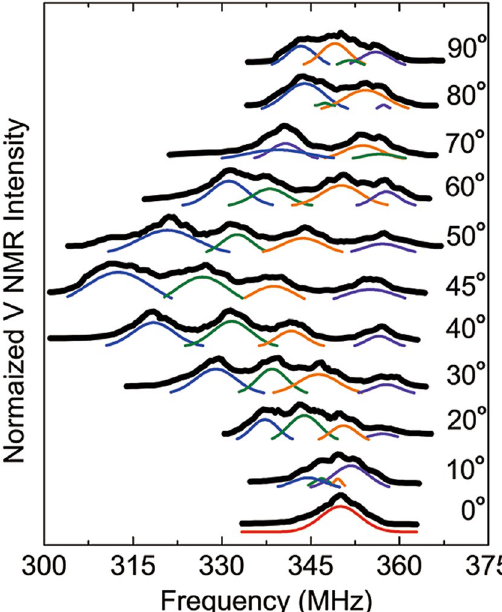
Figure 2. V 3 + NMR spectra of a MnV 2 O 4 single crystal measured at various directions of an external magnetic field of 7 T at the temperature of liquid helium. The solid curves are the gaussian fits to the decomposed